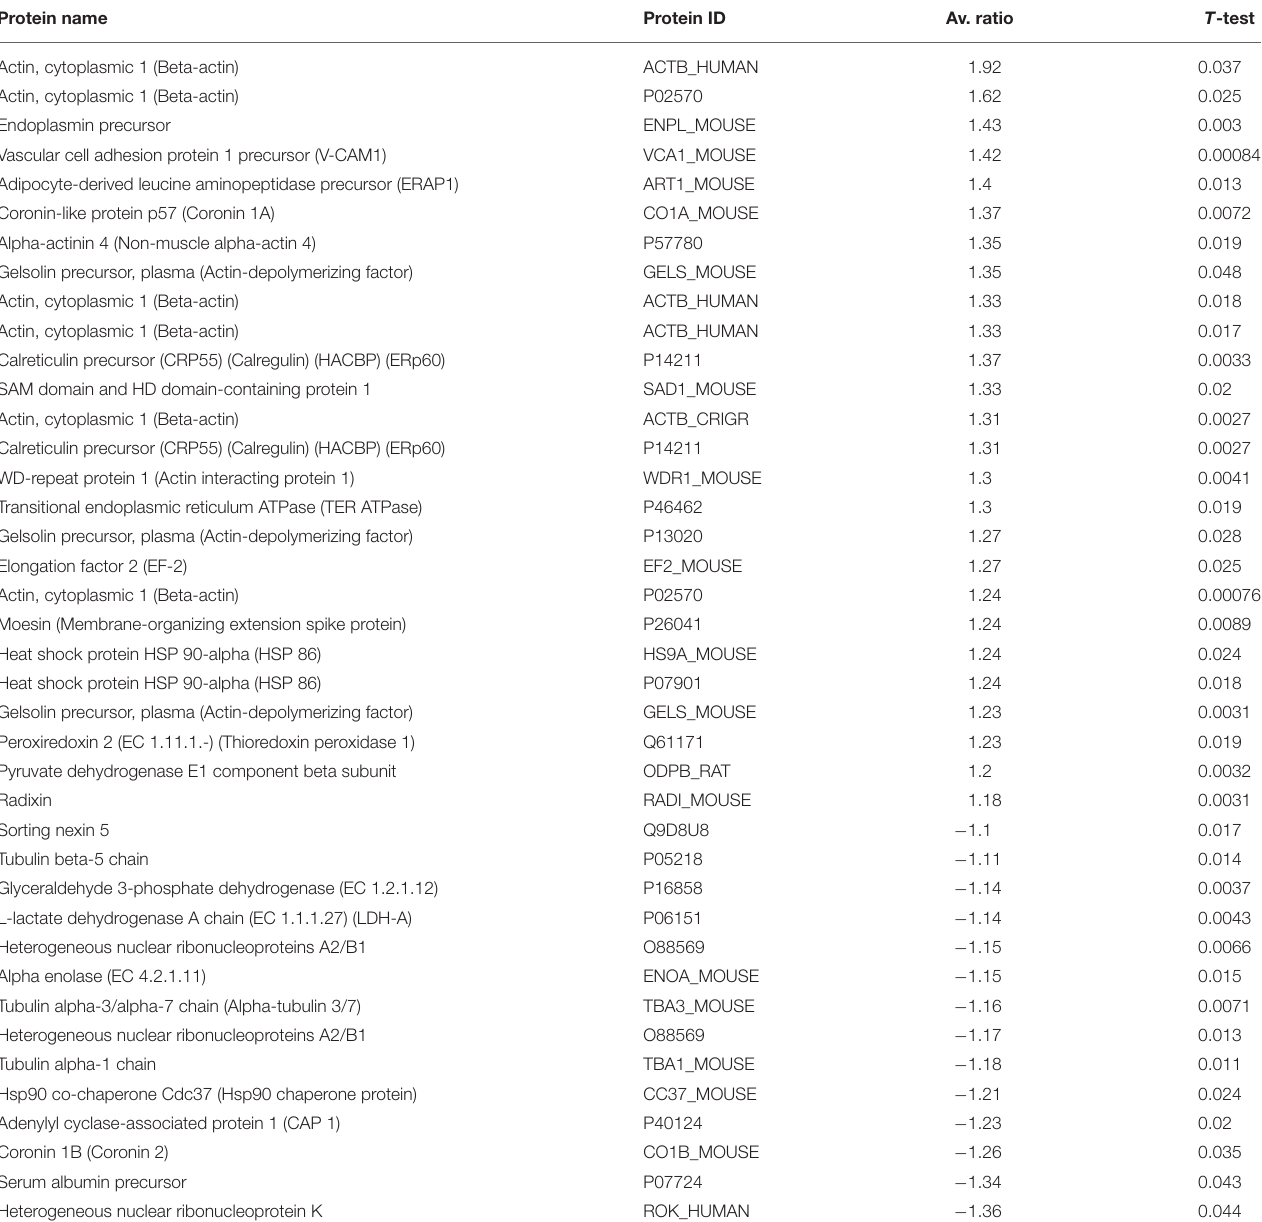
TABLE 1 | Identified protein spots from spleen that were significantly increased or decreased 8h after IP kynurenine administration (300